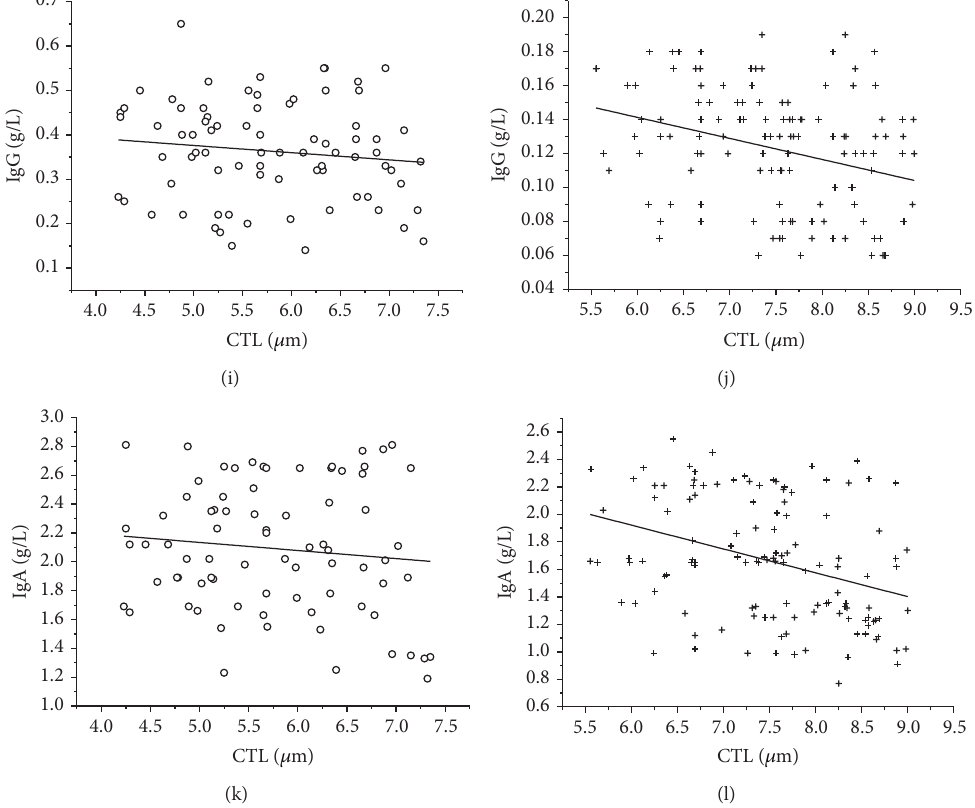
Figure 2: Correlation between MDA and IgG, IgA level in lymphocytes of workers in control group ((a), 𝑟 = −0.498 , 𝑃 < 0.001 ; (c), 𝑟 = −0.363 , 𝑃 = 0.001 ) and exposed group ((b), 𝑟 = −0.606 , 𝑃 < 0.001 ; (d), 𝑟 = −0.814 , 𝑃 < 0.001 ), respectively; correlation between 8-OH-dG and IgG, IgA level in lymphocytes of workers in control group ((e), 𝑟 = −0.229 , 𝑃 = 0.004 ; (g), 𝑟 = −0.080 , 𝑃 = 0.486 ) and exposed group ((f), 𝑟 = −0.405 , 𝑃 < 0.001 ; (h), 𝑟 = −0.523 , 𝑃 < 0.001 ), respectively; correlation between CTL and IgG, IgA level in lymphocytes of workers in control group ((i), 𝑟 = −0.126 , 𝑃 = 0.270 ; (k), 𝑟 = −0.110 , 𝑃 = 0.339 ) and exposed group ((j), 𝑟 = −0.312 , 𝑃 < 0.001 ; (l), 𝑟 = −0.350 , 𝑃 < 0.001 ),